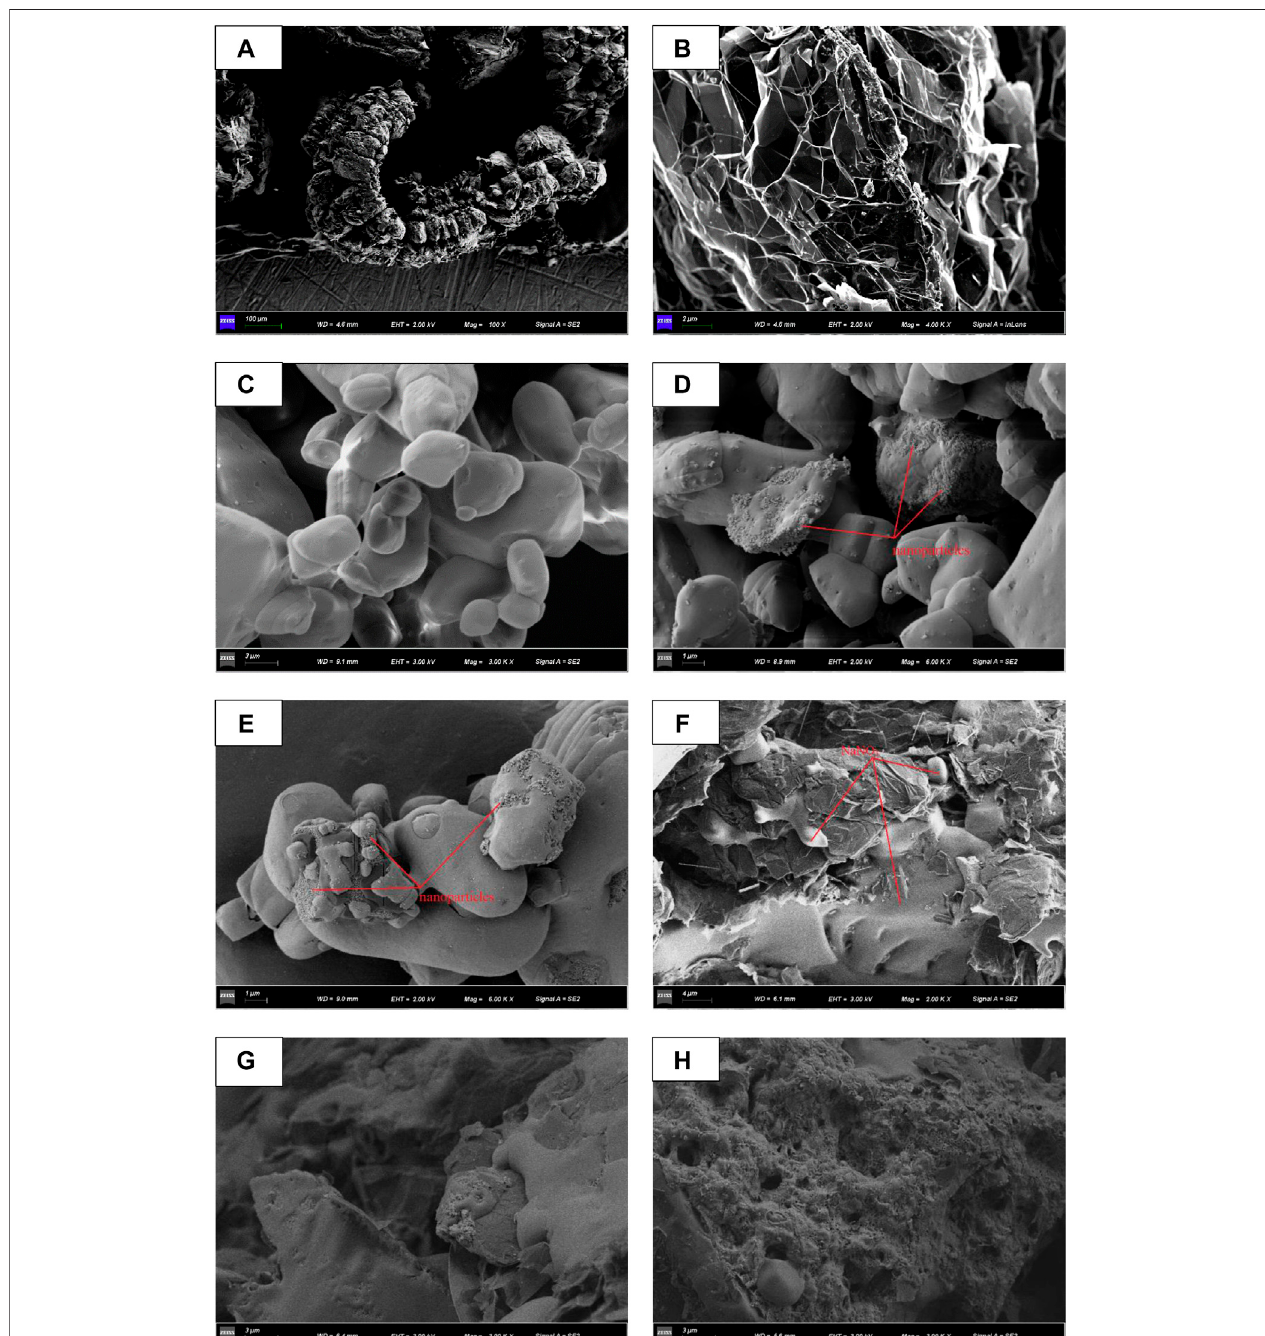
FIGURE 5 | SEM image (A, B) EG, (C) NaNO 3 , (D) NaNO 3 /SiO 2 , (E) NaNO 3 /(SiO 2 +TiO 2 ). (F) NaNO 3 /EG, (G) NaNO 3 /SiO 2 /EG, (H) NaNO 3 /(SiO 2 +TiO 2 )/EG.